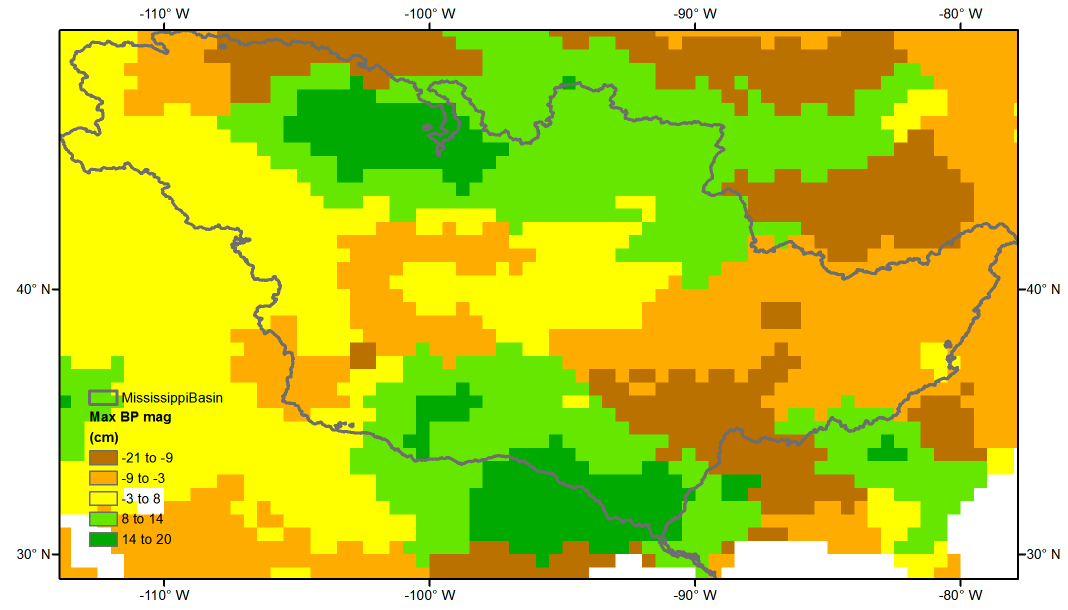
Figure 8. Maximum BP (in absolute magnitude) obtained for each grid block in Mississippi River basin.